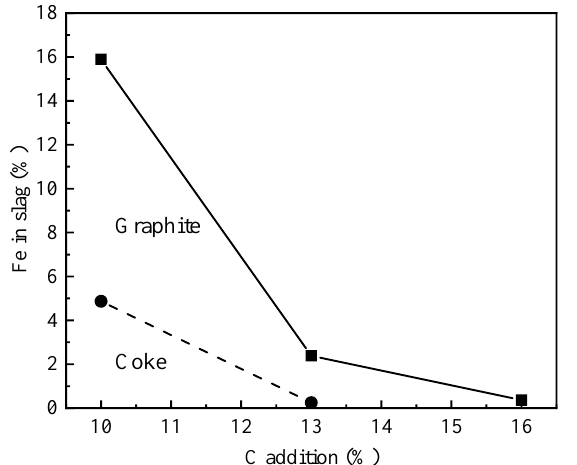
Figure 8. Effect of carbon type on iron content in the reduced slags after reduction at 1400 °C and 5% CaO addition.